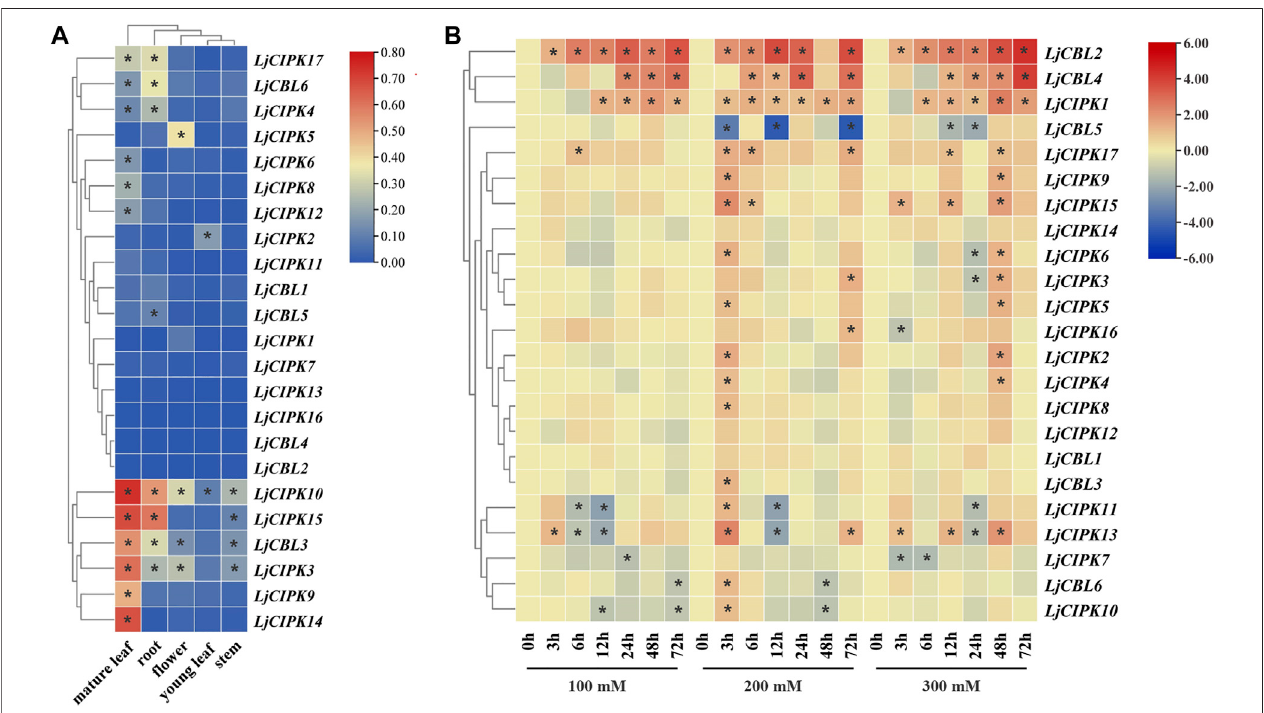
FIGURE 6 | Expression patterns of CBL-CIPK genes in different tissues (A) and under salt stresses (B) (A) The relative mRNA abundance of the CBL-CIPK was quanti fi ed in fi ve tissues. All values were expressed relative to the expression levels of reference genes using formula 2 − Δ Ct (Wang et al., 2020). Different colors indicate differentlevelsofgeneexpression;theasteriskindicatestherelativeexpressionlevelwaslessorgreaterthan0.05 (B) TheexpressionpatternsoftheCBL-CIPKat0,3,6, 12, 24, 48, and 72 h after treated with NaCl (100, 200, and 300 mM NaCl). All values were expressed relative to the expression levels of reference genes using formula 2 − ΔΔ Ct . Ljactin was used as a marker gene. Different colors indicate different levels of gene expression based on the log2 value of the fold change by RT-qPCR; blue indicates downregulation, and red indicates upregulation. The asterisk indicates signi fi cant ( p < 0.05) up/down-regulated expression ( >